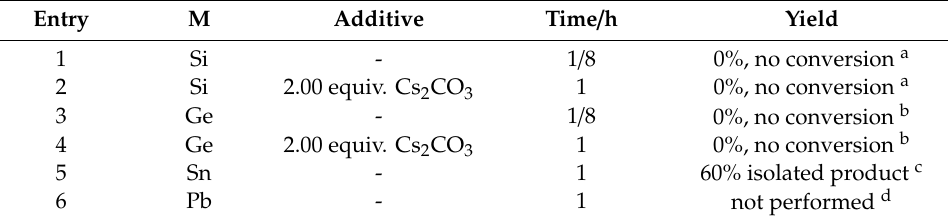
Table 1. Overview of used substrates and reagents for the synthesis of dimetalated azobenzenes.